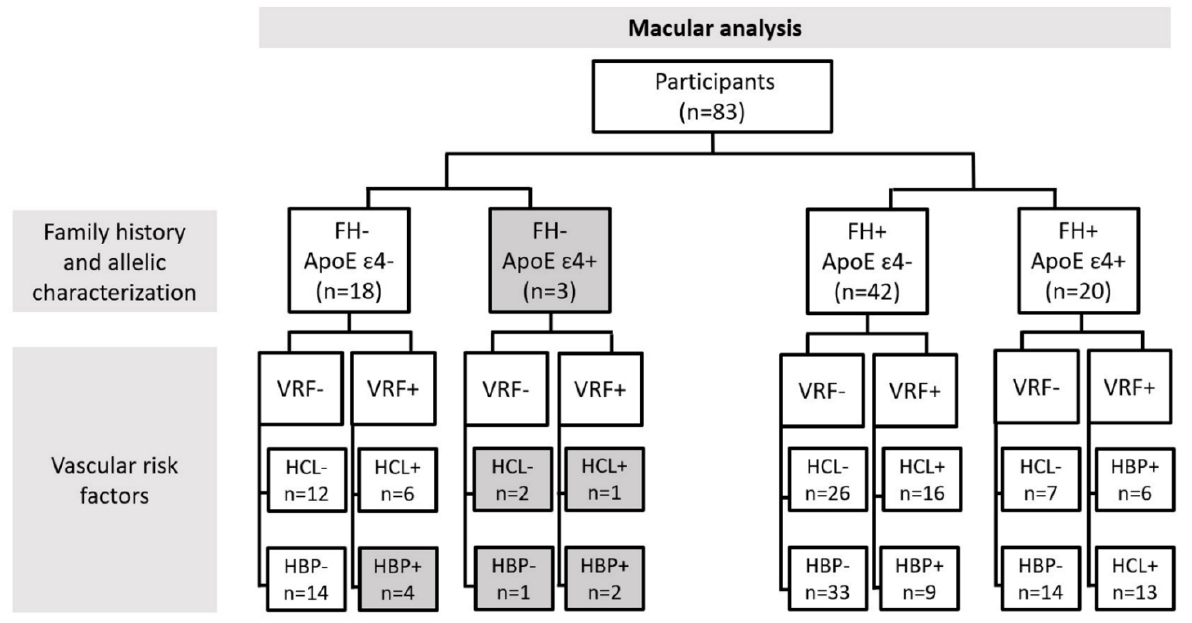
Figure 1. A flow diagram of the study groups according to the different characteristics for which the vascular network of the macular area was analyzed: FH: family history of AD; ApoE: Apolipoprotein E; VRF: vascular risk factors; HCL: hypercholesterolemia; HBP: high blood pressure.